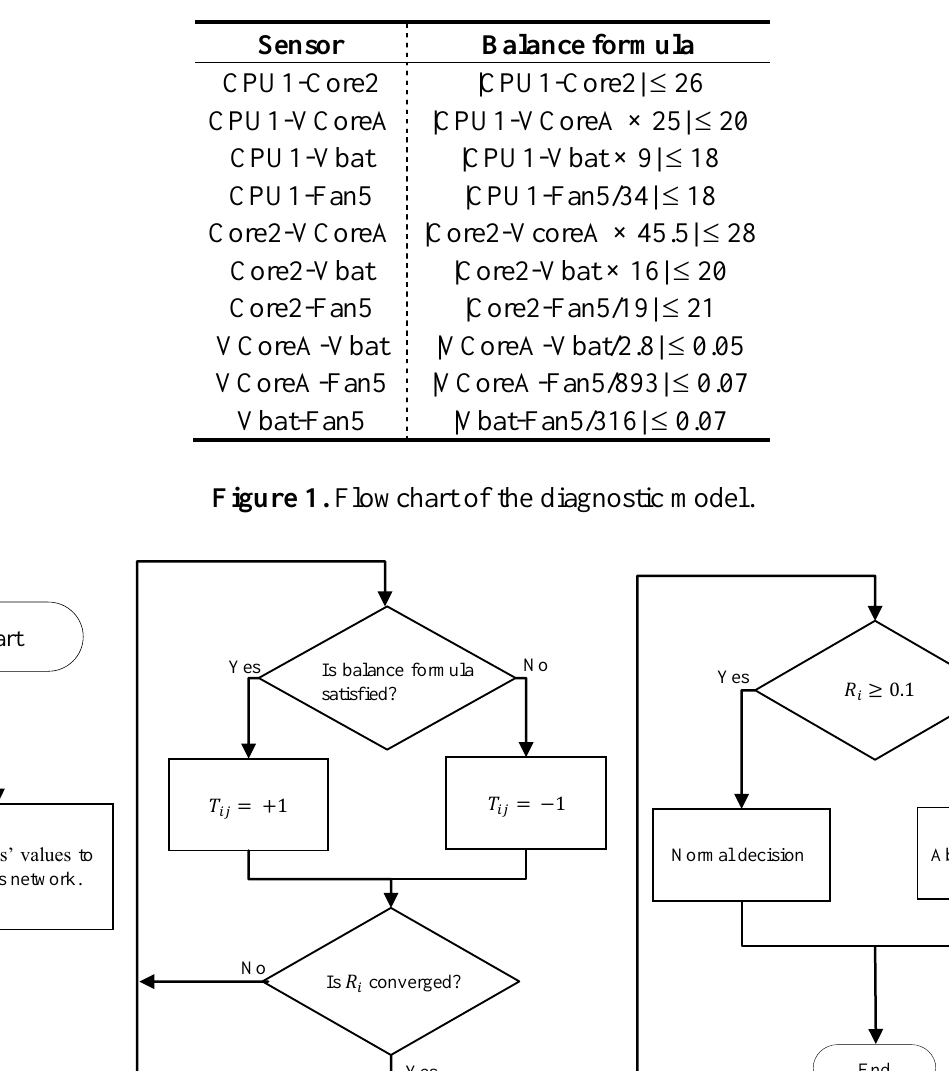
Table 3. Balance formulas between sensors.